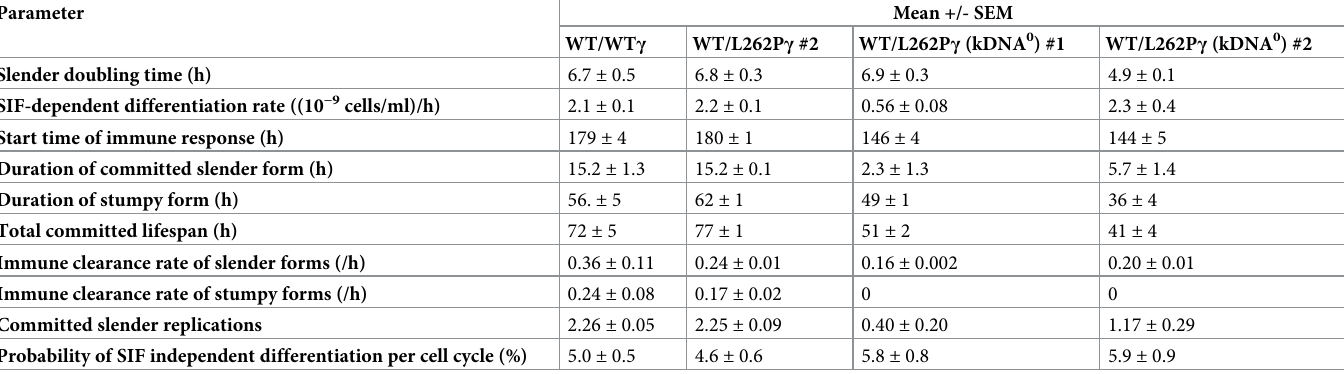
Table 2. Average parameter estimates for all cell lines. Shown are parameter estimates determined from the model with both SIF-dependent and -independent differen- tiation